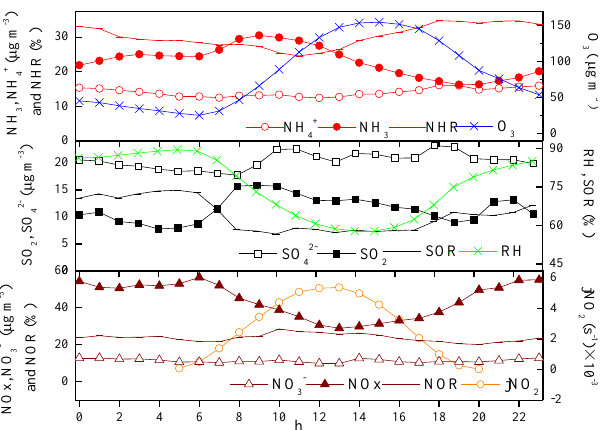
Figure 8. Diurnal variation in NHR, SOR, NOR, gaseous precur- sors, major water-soluble ions, and meteorological factors in sum- mer 2013.